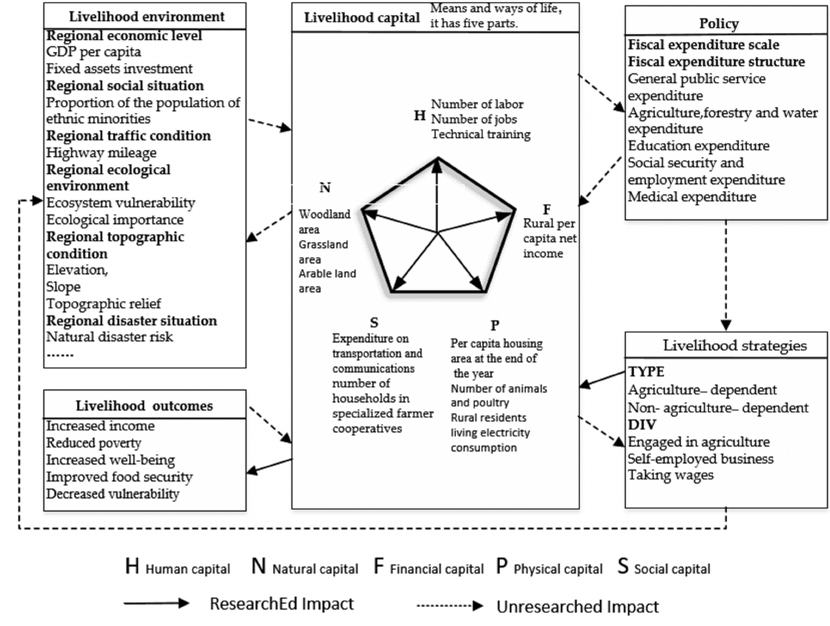
Figure 1. Research framework.